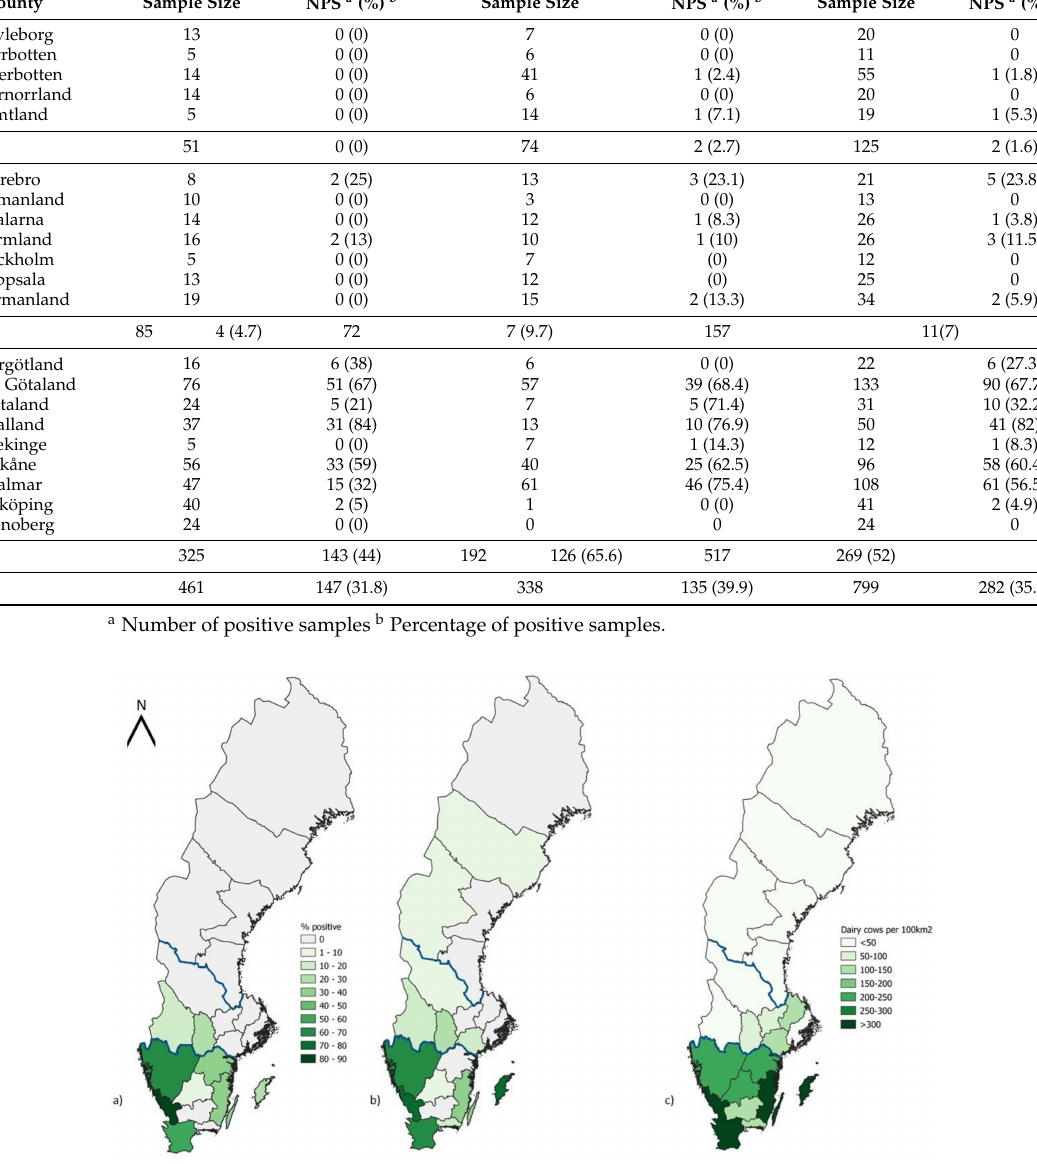
Figure 1. Maps of Sweden displaying the counties and the borders of the northern, central and southern regions. ( a ) The proportion of bulk milk samples in which IDV-specific IgG antibodies were detected in 2019, ( b ) the proportion of bulk milk samples in which IDV-specific IgG antibodies were detected in 2020, and ( c ) dairy cow density. The blue lines highlight the border of the different